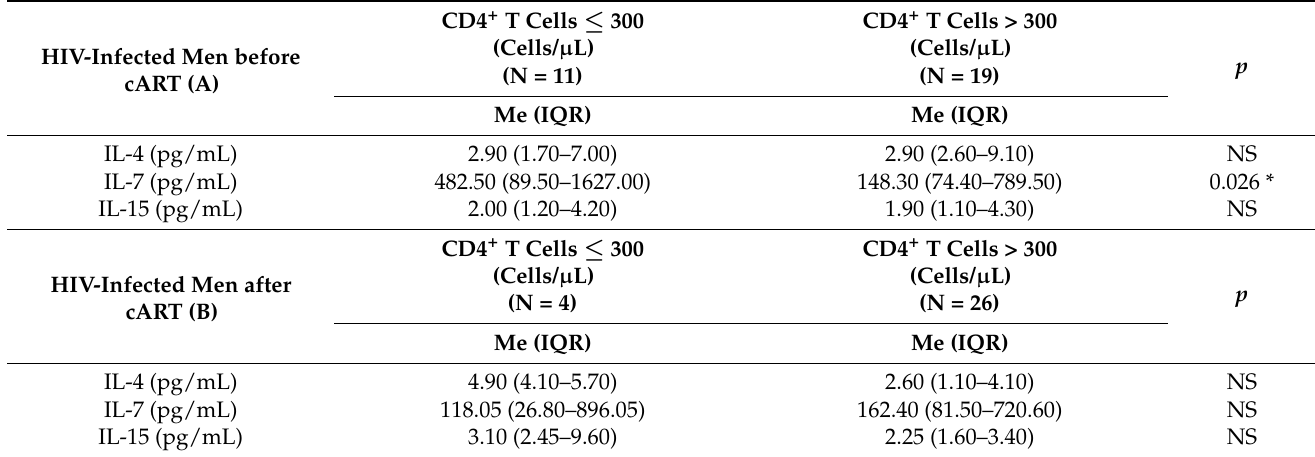
Table 4. Results of IL-4, -7 and -15 before (group A) and after (group B) cART in HIV-infected men by CD4 + T-cell count (below and above 300 cells/ µ L) with statistical